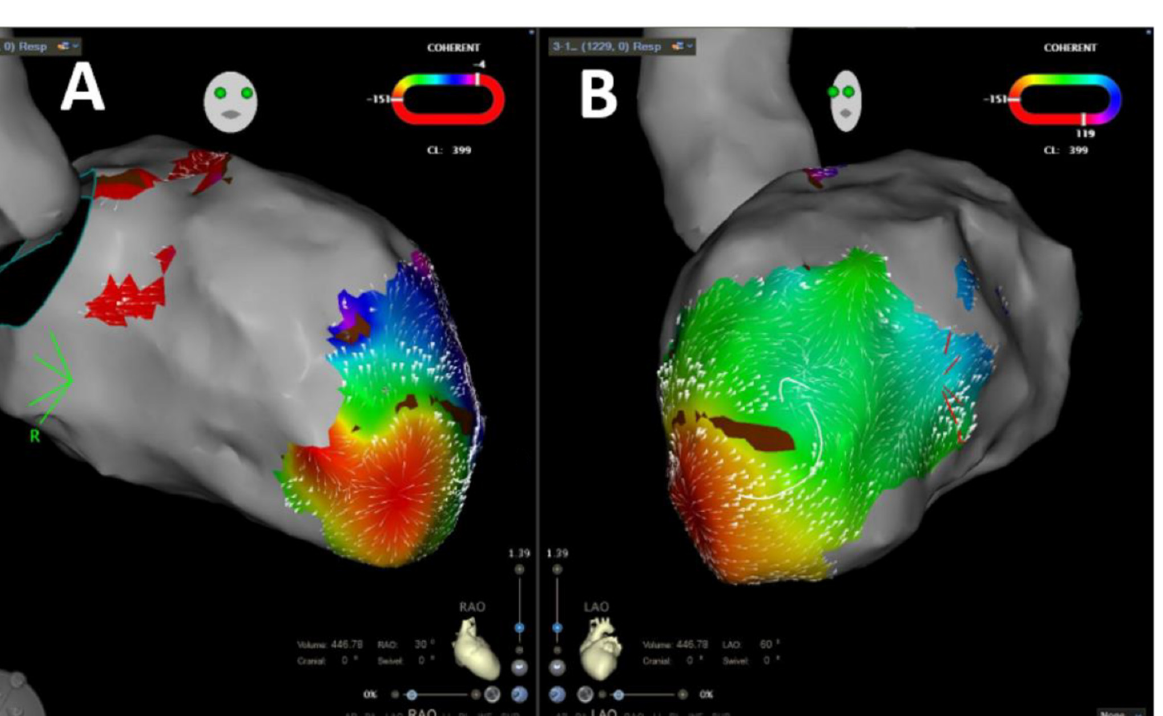
Figure 3. Representative image of left ventricular velocity-vector-based coherent mapping in com- bination to bipolar voltage mapping in RAO ( A ) and LAO ( B ) projections.